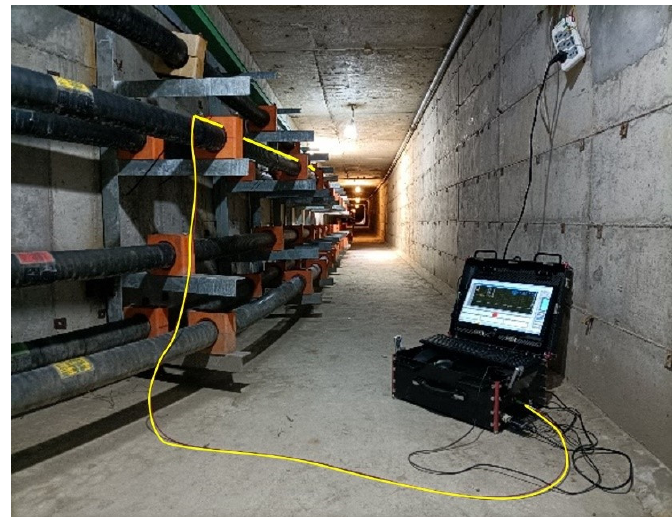
Figure 8. The cable temperature monitoring site.